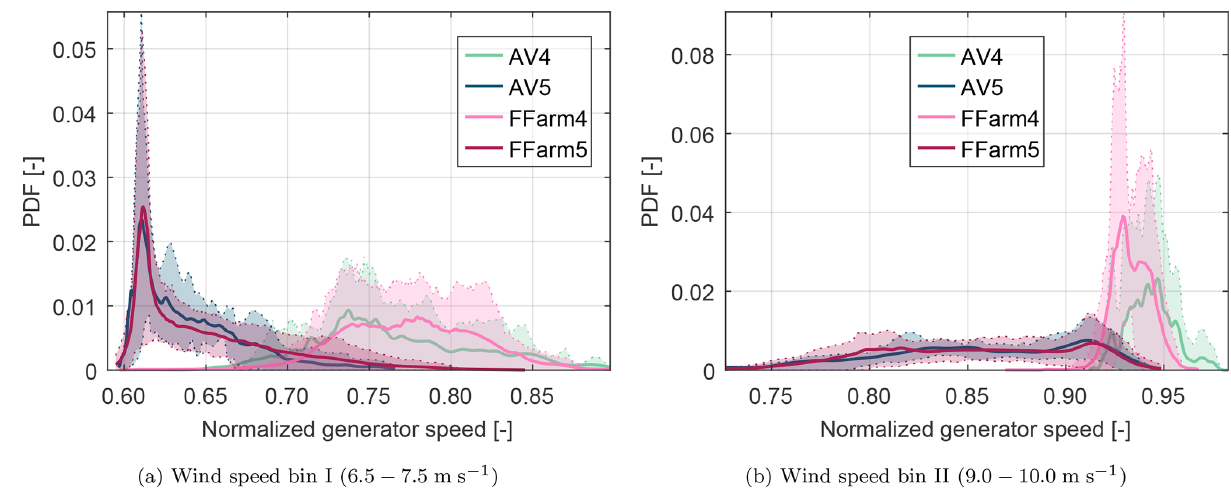
Figure 7. Probability density function (PDF) of generator speed for measurements (AV4, AV5) and simulations (FFarm4, FFarm5) in the wind direction sector 270.75–273.25 ◦ . Thick lines show the mean of the PDFs of all considered events. The shaded area indicates the 15th and 85th